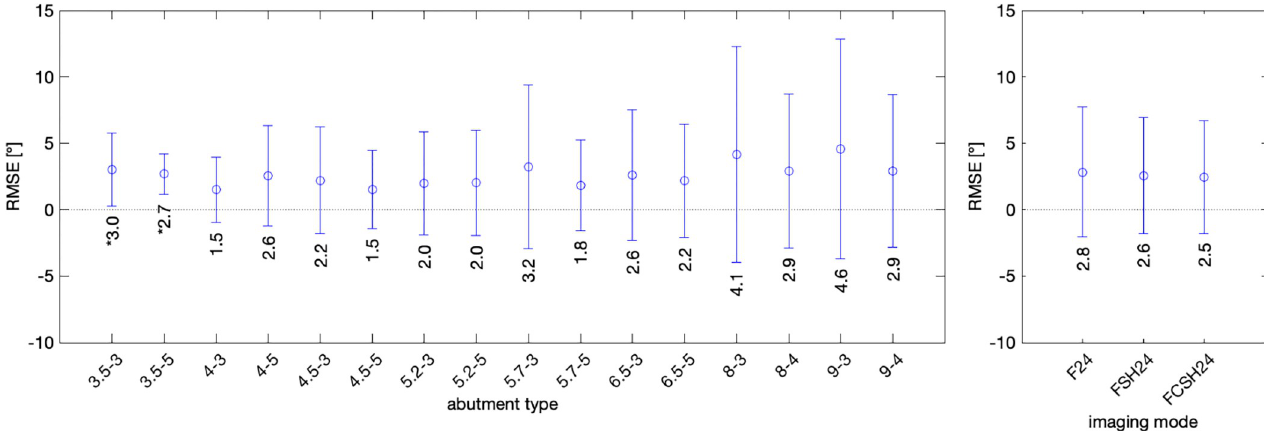
Fig 7. Left graph: Root mean squared error (RMSE) in measuring abutment angles of the 16 specimens. The RMSE is the range of 1.5 to 4.6 degrees. Right graph: Mean RMSE in degrees and confidence interval error bars across 16 abutment types for each imaging mode (F24, FSH24, and FCSH24). The RMSE is in the range of 2.5 to 2.8 degrees for all 3 modes without statistical